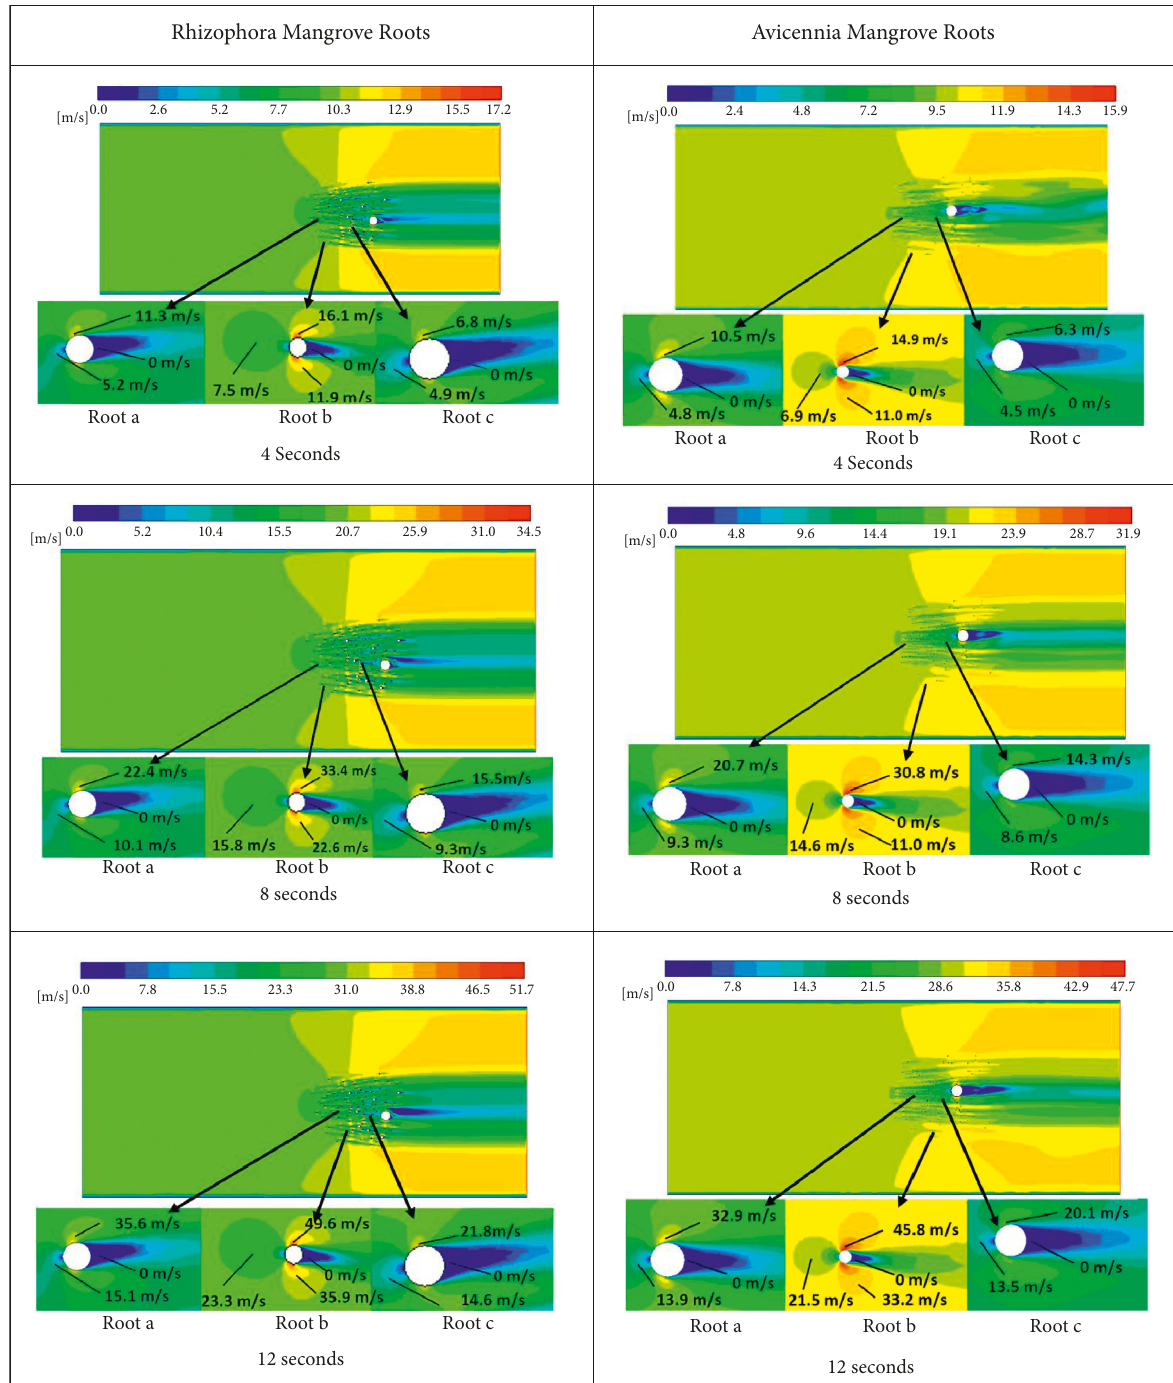
Figure 6: Velocity profile of incompressible unsteady air flow at time intervals of 4 seconds, 8 seconds, and 12